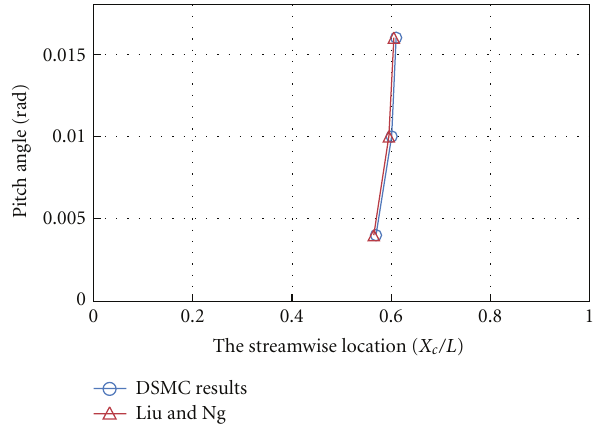
Figure 3: Comparison of streamwise locations of the slider bearing forces from the present DSMC code and those of Liu and Ng [10].